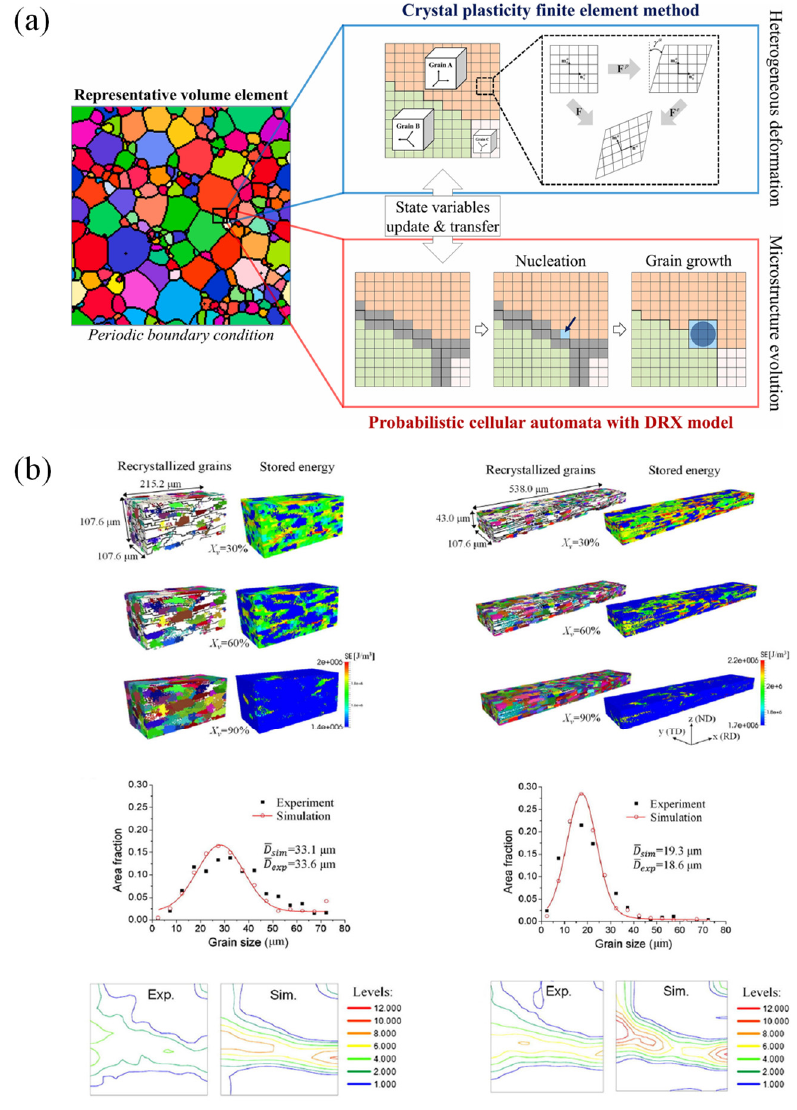
Figure 5. ( a ) A framework for the integrated CPFEM approach [31] and ( b ) an example of numerical simulations coupled with the microstructure evolution [30]. Reproduced with permission [31]. Cop-